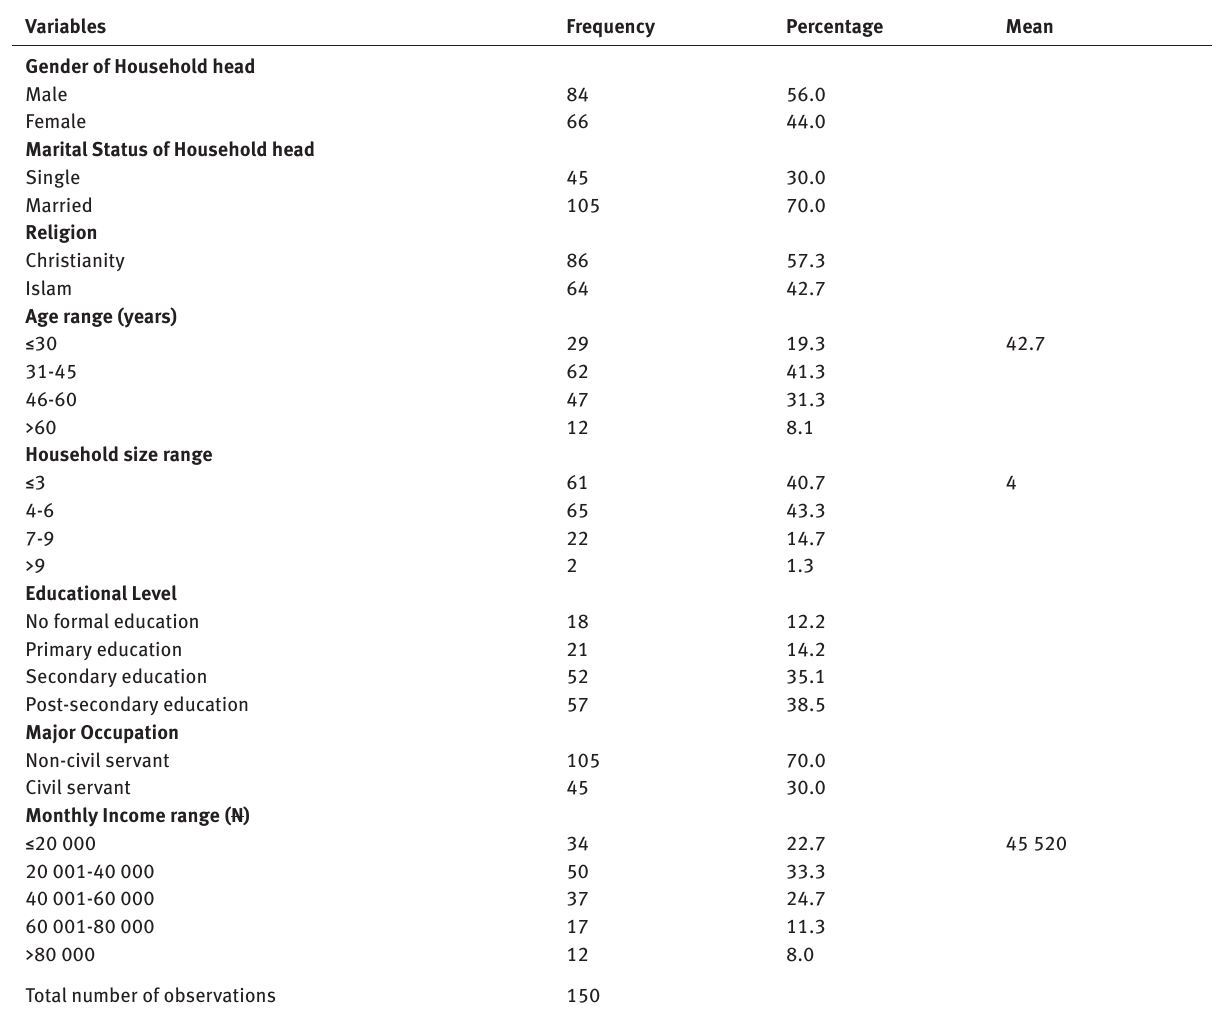
Table 1: Socioeconomic characteristics of respondents and respondents